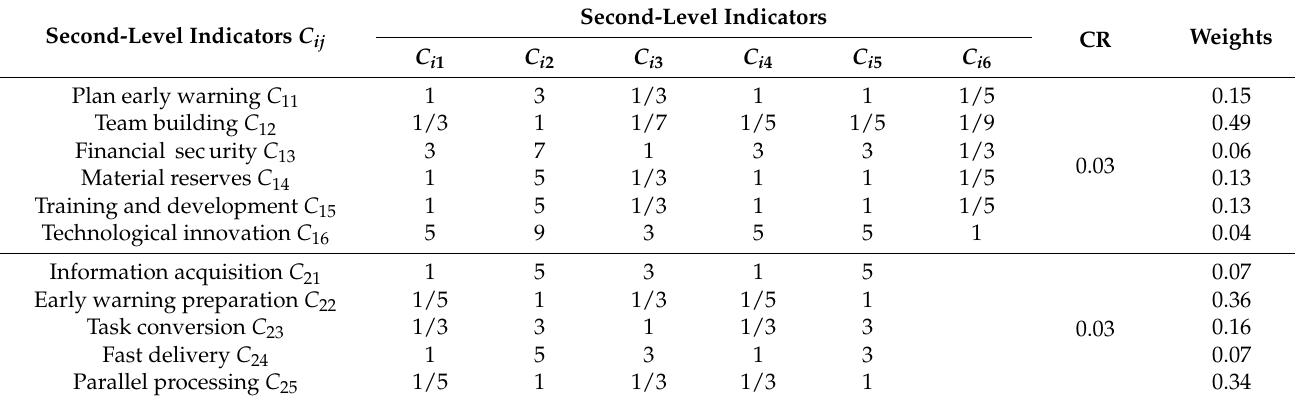
Table A9. Judgment matrices and weights of second-level assessment